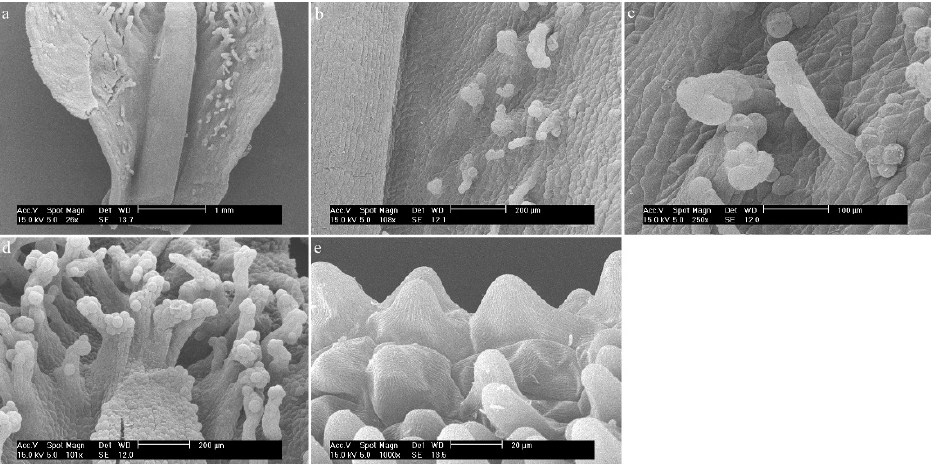
Figure 15. Dendrobium katherinae A.D.Hawkes: ( a ) the hypochile and the mesochile part of the labellum; ( b ) the hypochile part of the labellum; ( c ) the initial part of the mesochile of the labellum; ( d ) final part of the mesochile of the labellum; ( e ) papillae of the epichile part of the labellum.